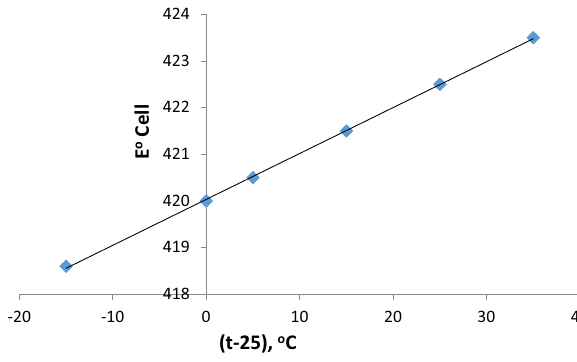
Fig. 6 Variation of the cell emf with the temperature for the modified SPE sensor